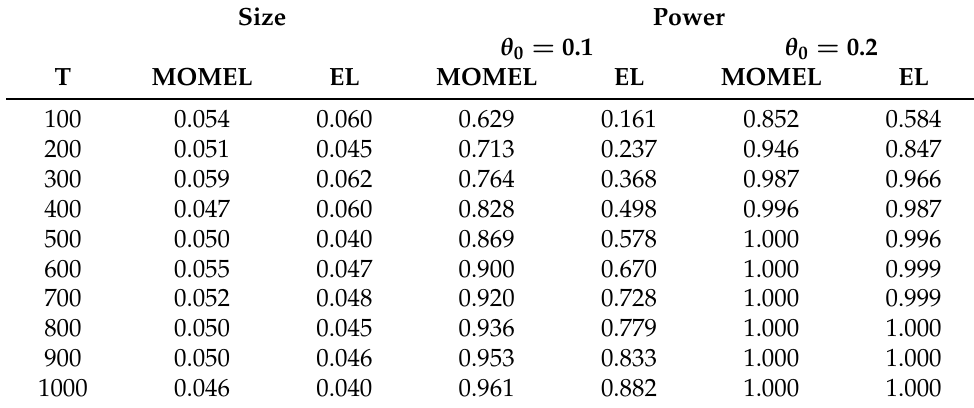
Table 4. Size and power in Example 4.